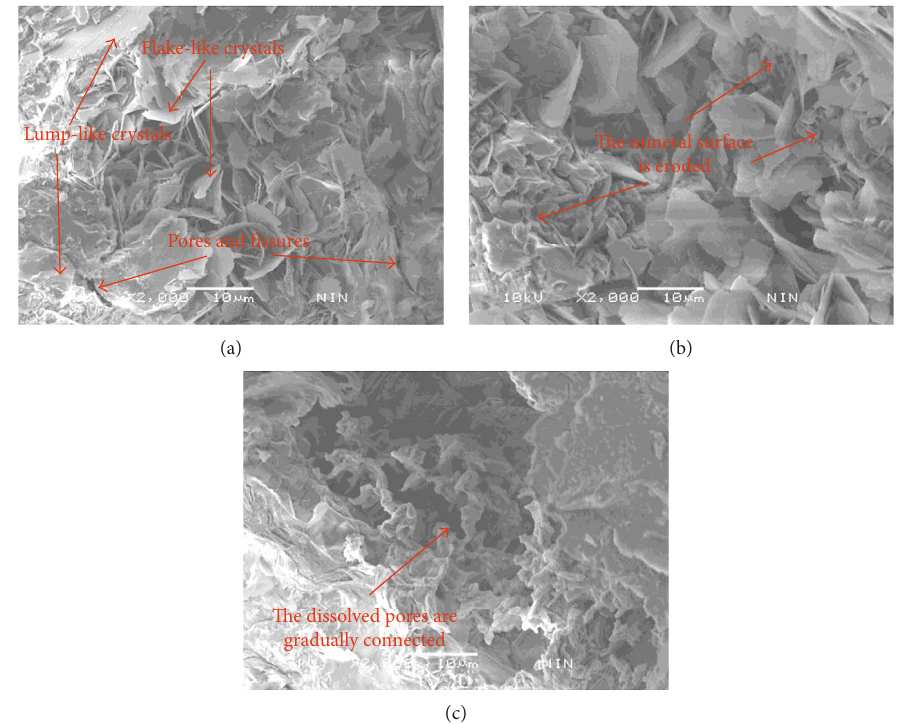
Figure 12: SEM images of the sandstone samples attacked by pH � 1 H sulfuric acid solution for (b) 30 days and (c) 90